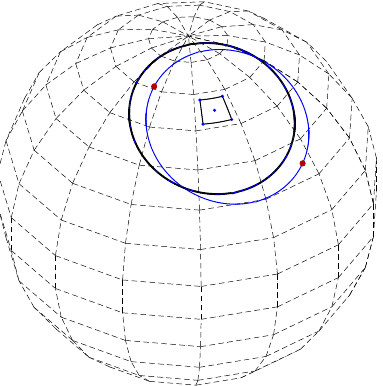
Figure 11. A secondary circle (black) and a corner circle (blue). The maximum distance of a point on the corner circle to the secondary circle is achieved by the two critical points